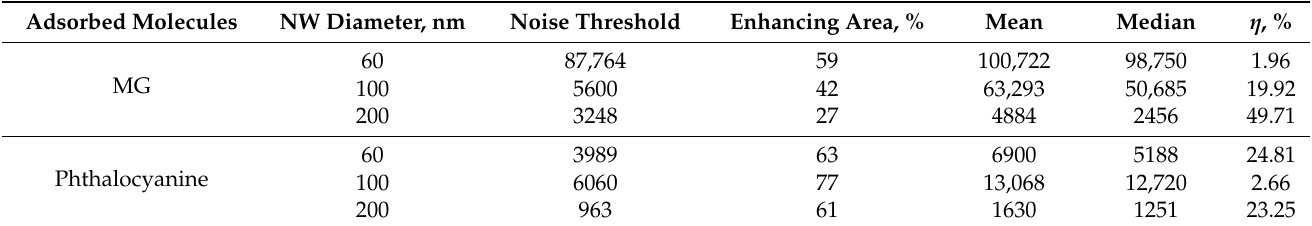
Table 1. Summary of the investigated SERS-active substrates efficiency. Adsorbed